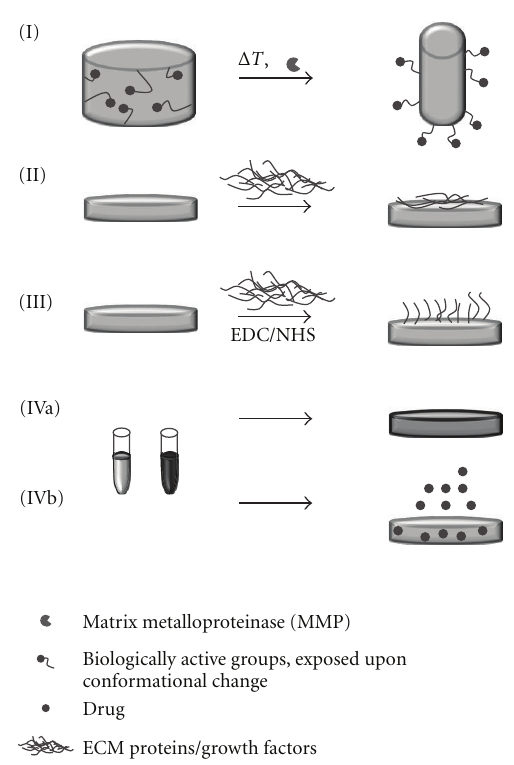
Figure 2: Schematic illustration of di ff erent functionalization prin- ciples. (I) Smart materials, changing conformation, and exposing di ff erent chemical groups upon temperature change or a change in enzyme concentration. (II) Surface functionalized materials. A synthetic sca ff old is immersed in a ECM protein solution, allowing for protein adsortion on the surface. (III) Covalently functionaliz- ed sca ff olds. Functional proteins are coupled to the surface via EDC/NHS chemistry. (IV) Blend materials, (a) hybrid sca ff olds of various polymers or (b) hybrid sca ff olds of polymers and drugs for controlled